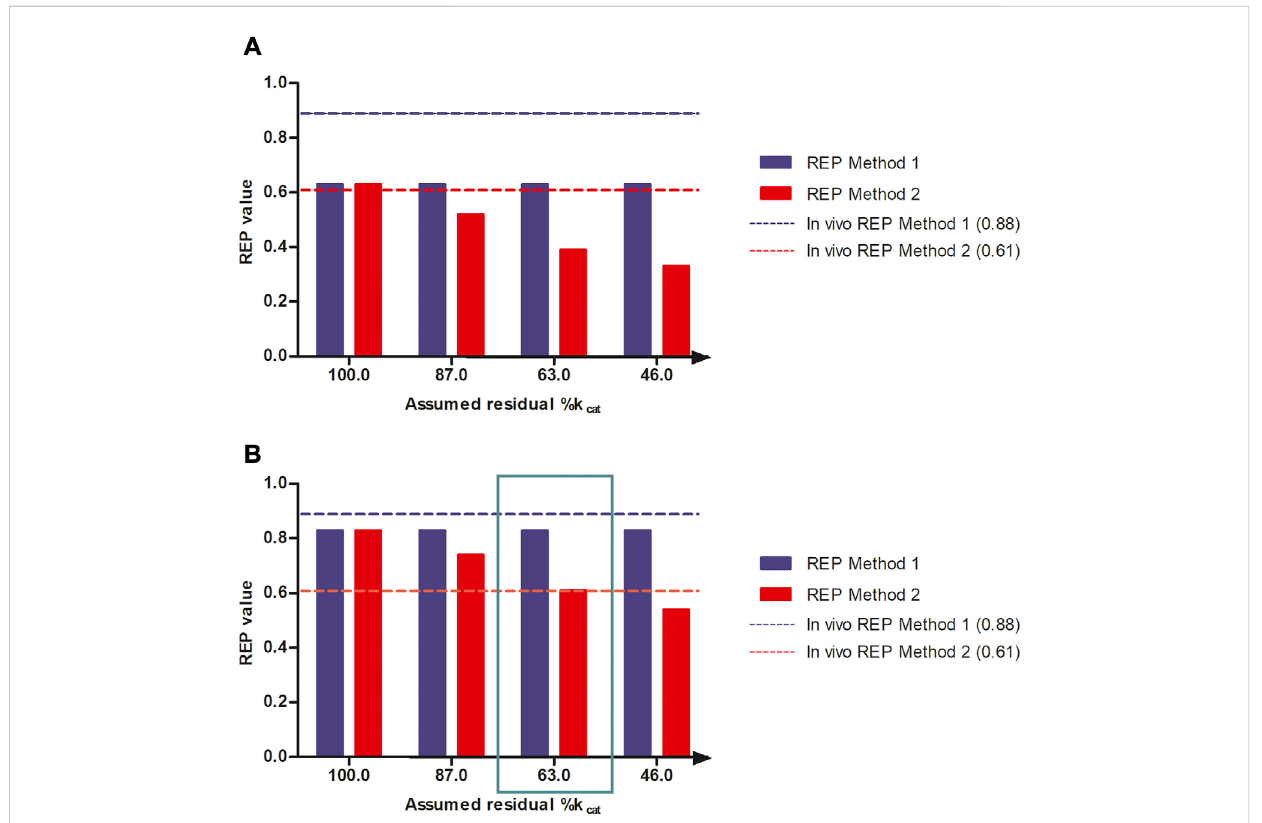
FIGURE 5 REP values when calculated based on PBK modeling-based predictions with increasing reduction in k cat for 7-GS-DHP formation when dosing SEN because of GSH depletion assuming (A) 100% bioavailability and (B) 8.20% bioavailability and using either the AUC PA (Method 1, blue bars) or the amount pyrrole-proteinadducts (Method2, redbars).Thereduction ink cat mimicstheconsequencesoftheGSHdepletionfor thek cat ofpyrrolescavenging by GSH upon dosing SEN. Simulations were performed at a dose level of 55 μ mol kg -1 bw of SENO and SEN as used by Yang et al. (Yang etal., 2017a) in their in vivo rat study. The blue and red horizontal lines represent the REP value derived from the in vivo study by Yang et al. (Yang et al., 2017a) (Table